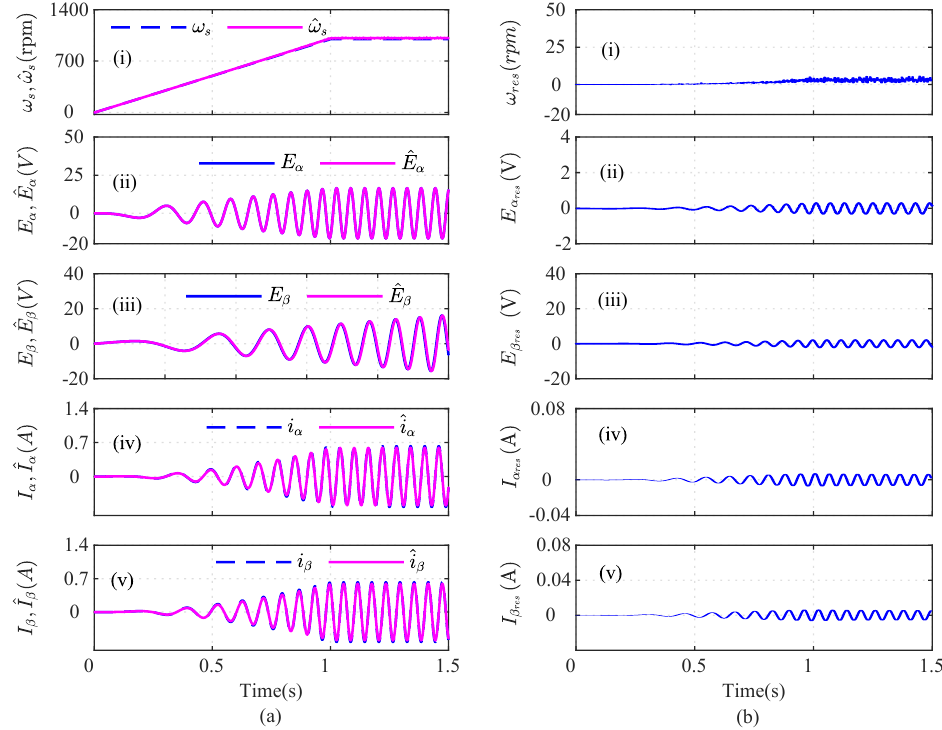
Figure 2. Illustration of current, speed, and voltage sensors’ observers during no-fault scenario; ( a ) actual and estimated signals; ( b )